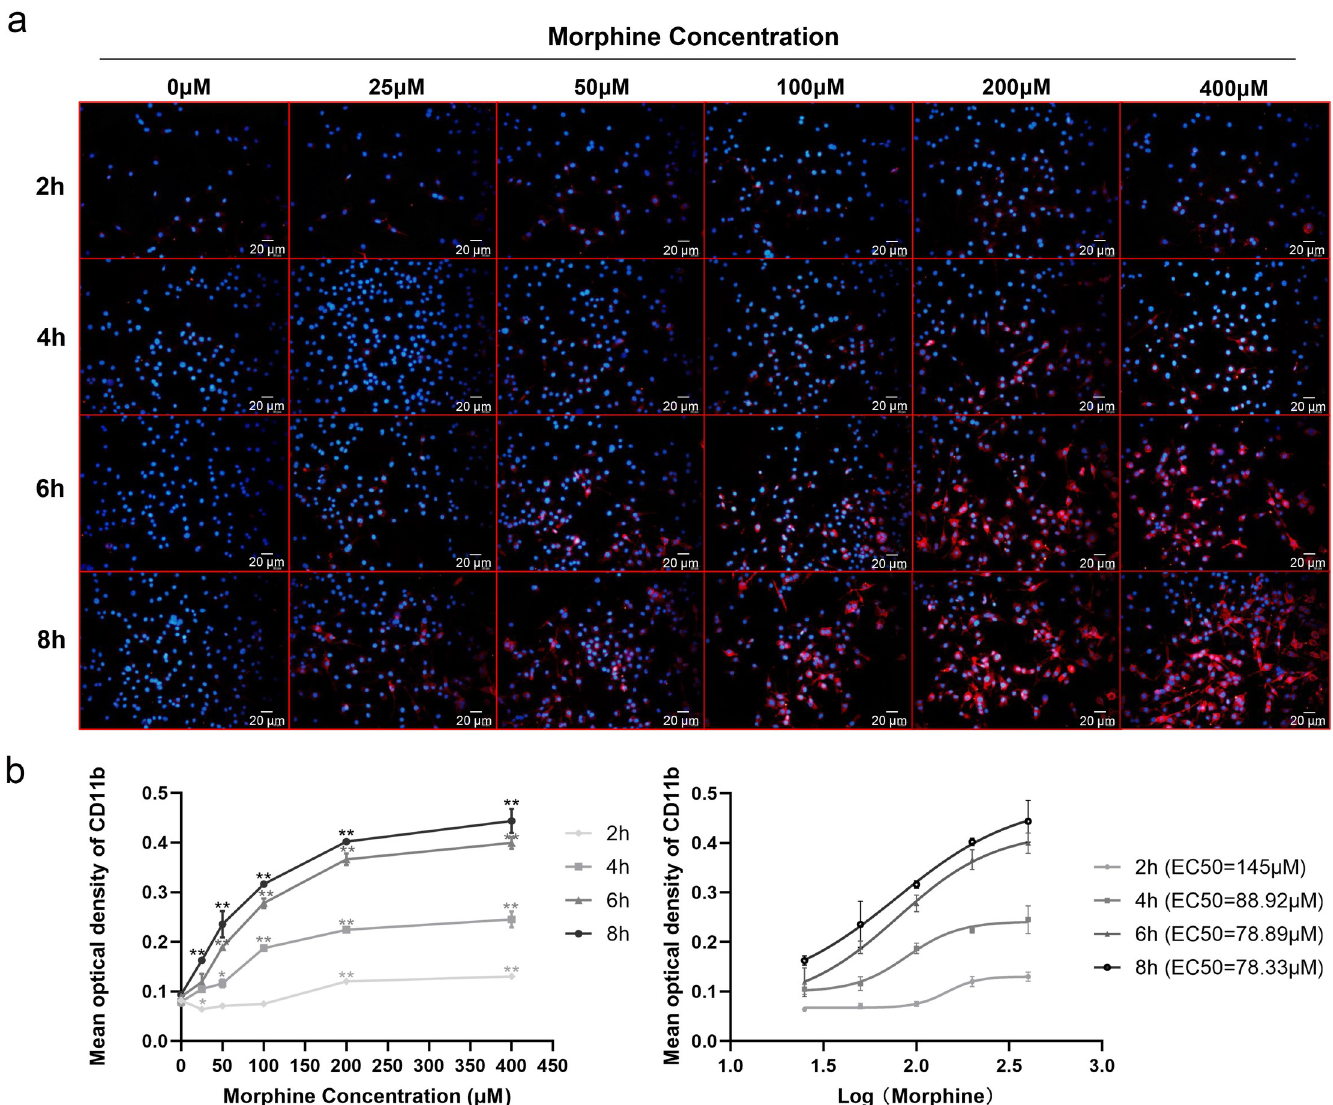
Fig 1. Morphine upregulates CD11b in a dose- and time-dependent manner in microglial BV-2 cells. BV-2 cells were treated with 0, 25, 50, 100, 200, and 400 μ M morphine for 2, 4, 6, and 8 h and tested by immunocytochemistry staining. (a) Time- and dose-response effect of morphine on the expression of CD11b. Scale bar: 20 μ m. (b) The time- and dose-response curve of BV-2 cells activated by morphine. Data were fit to a sigmoidal dose-response curve and EC50 values calculated using GraphPad Prism software. The mean optical densities of six randomly selected fields of cells from each group were analyzed by ImageJ software for quantitative analysis. Data are expressed as the means ± SEMs. All data were analyzed using ANOVA. � p < 0.05 and �� p < 0.01 were considered to be statistically significant compared to the control